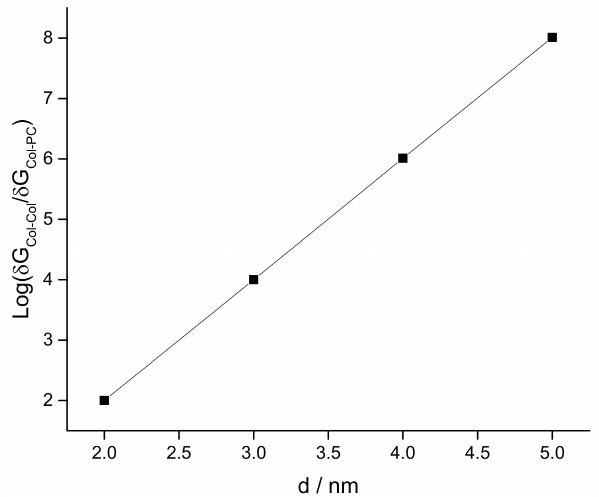
Figure 13. Plot of Log( δ G Col-Col / δ G Col-PC ) addresses on relative energetic cost a drug experiences to fall into a drug cluster from lipid bound state. δ G Col-Col and δ G Col-PC are the values of δ G for Col in Col cluster and Col in PC cluster, respectively (plotted independently in Figure 11). A = 1